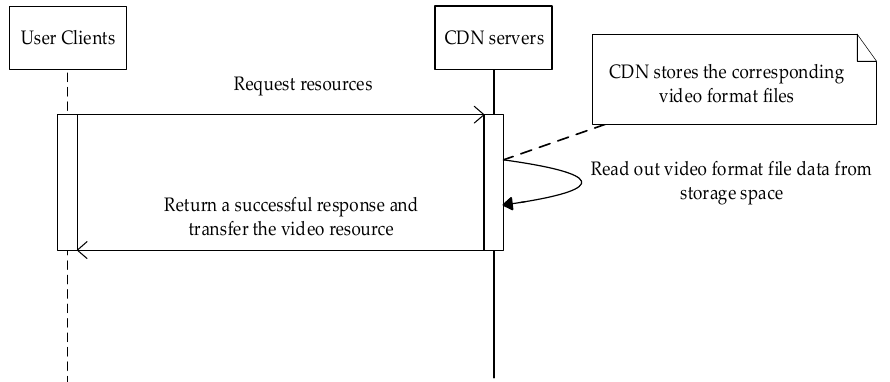
Figure 2. Flow-process diagram of the data service.